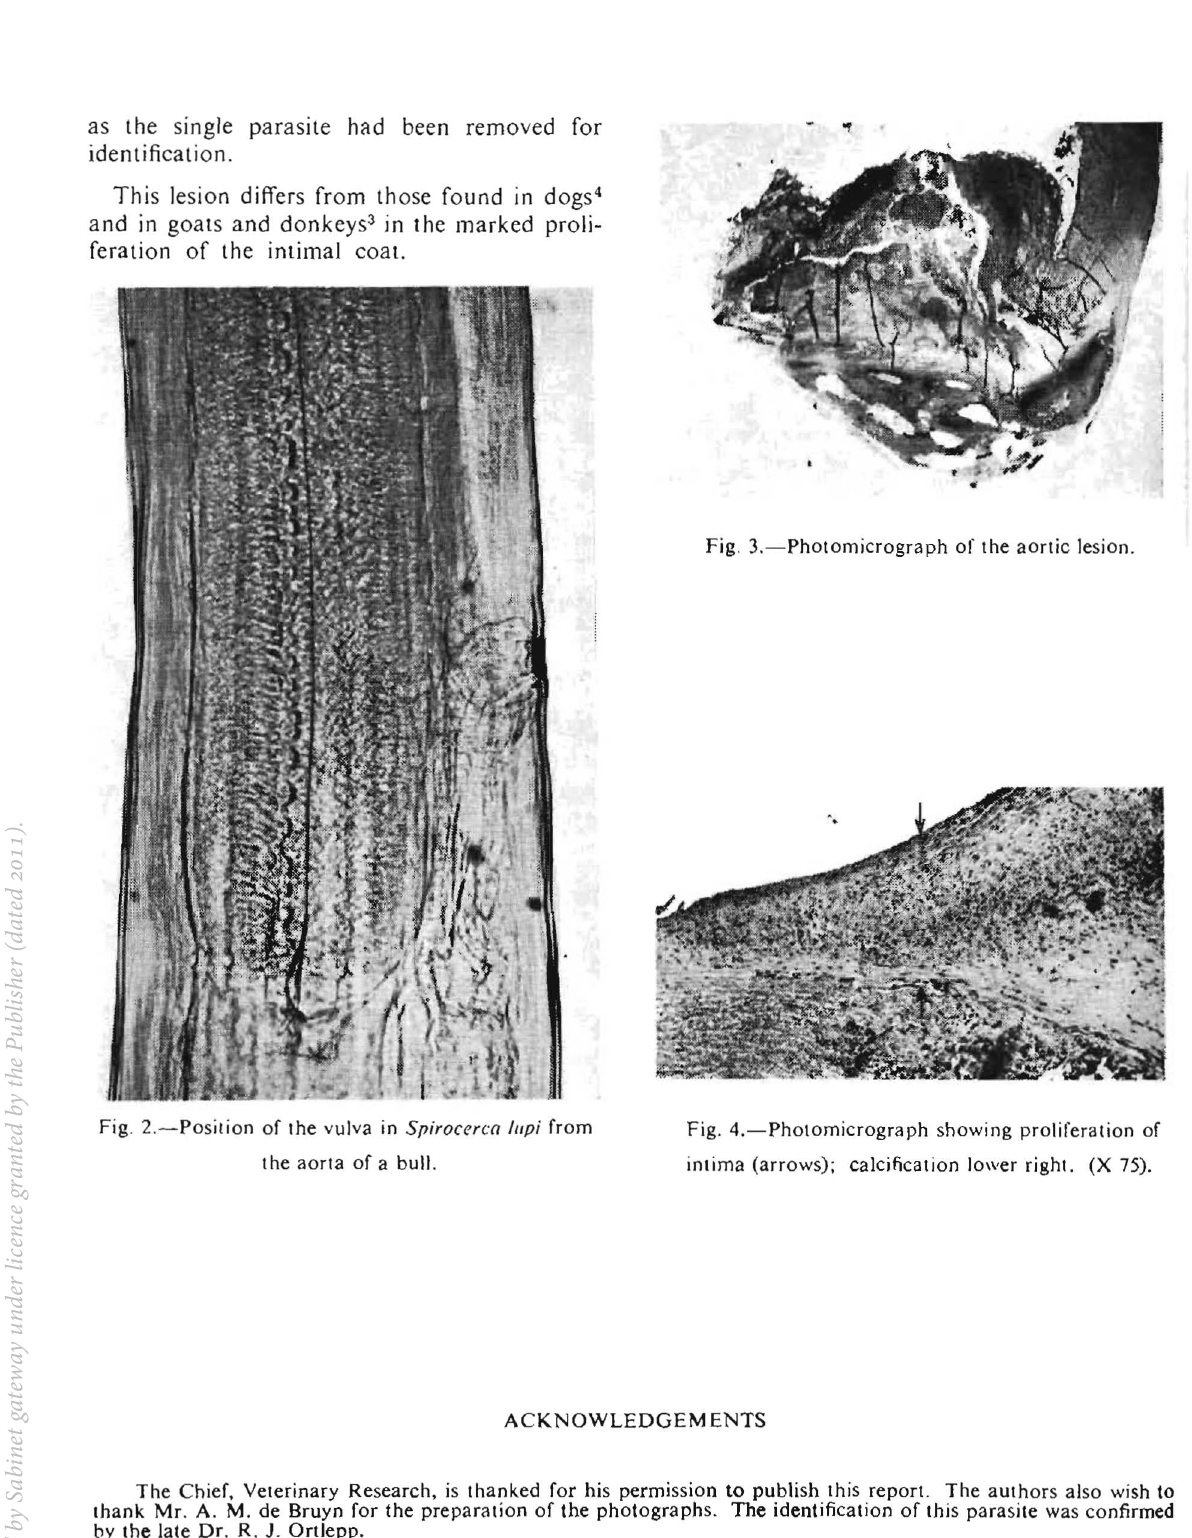
Fig. 2.-Position of the vulva in Spirocerca Illpi from t he aorta of a bull.